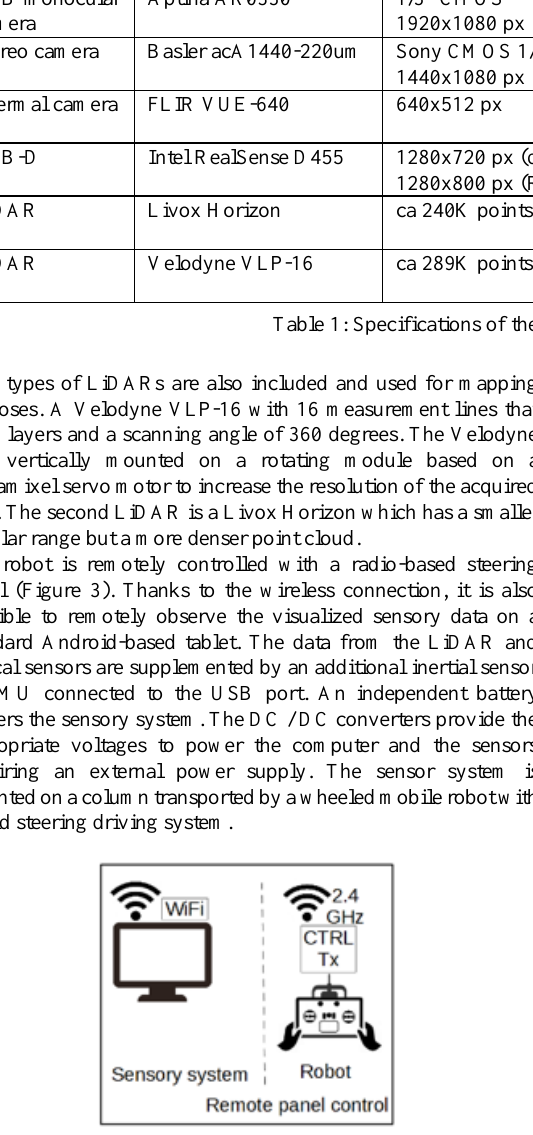
Figure 3: Remote control panel.